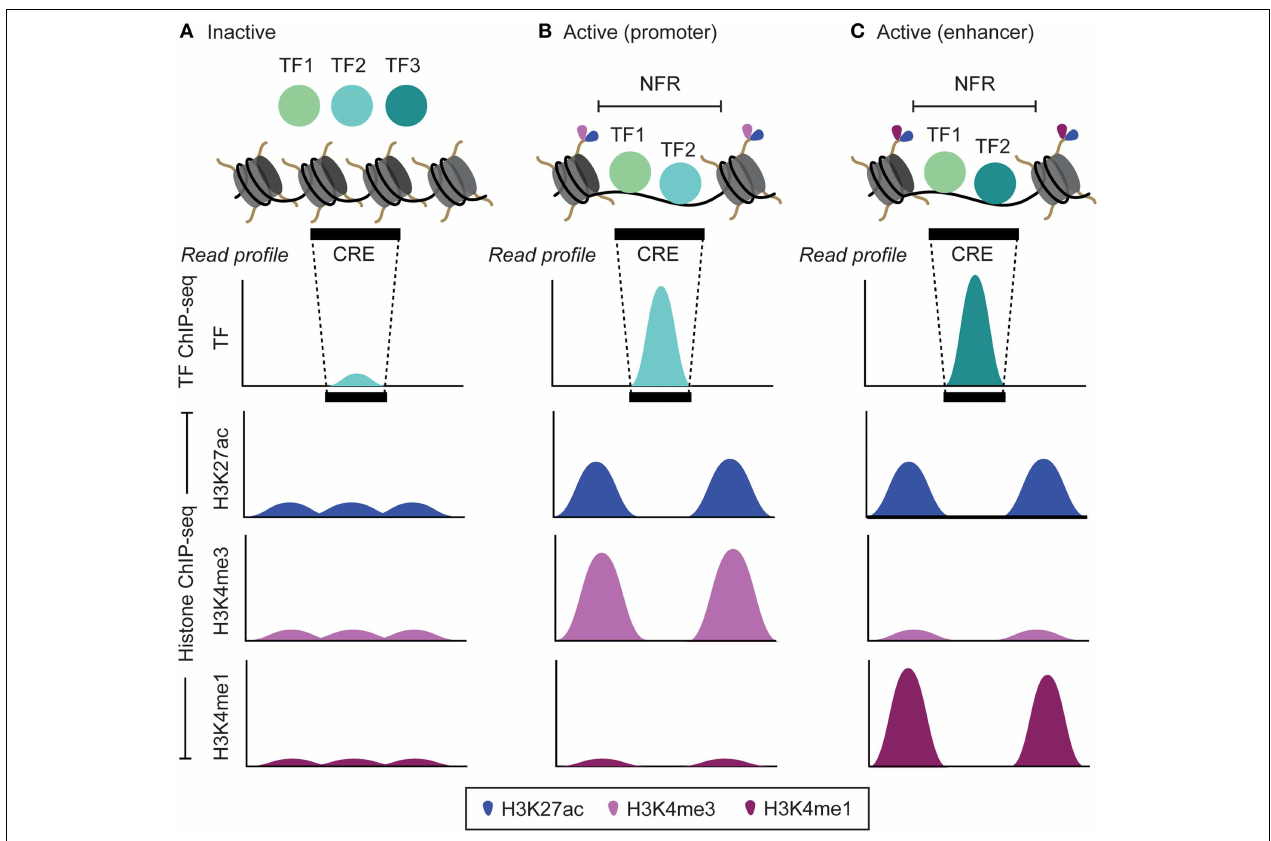
FIGURE 3 | The transcription factor and histone modification landscape for inactive and active cis -regulatory elements (CRE; promoters and enhancers) and the corresponding read profiles. (A) When inactive, the DNA corresponding to the CRE is wrapped around histone proteins in the form of a basic structural unit termed as nucleosome. This prevents any interaction of transcription factors (TF) with the DNA. (B,C) When active, a series of histone modifications (H3K4me1, H3K4me3, H3K27ac and others) along side interaction with specific TF (pioneer factor) make the overlapping nucleosomes at a CRE hypermobile. These nucleosomes are then displaced apart leading to formation of nucleosome free regions (NFRs) that are subsequently bound